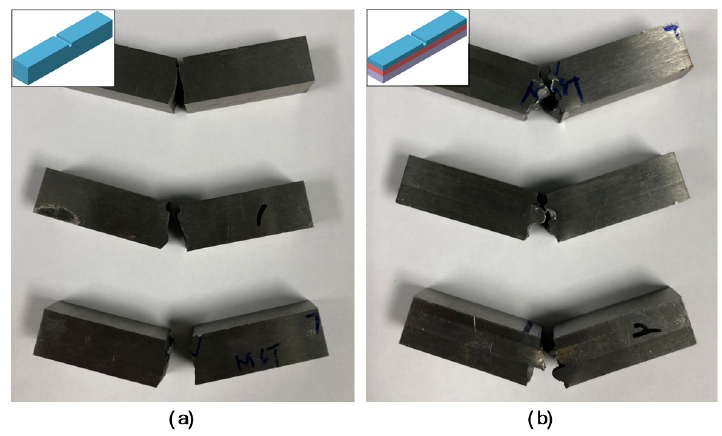
Figure 9. State of the specimens after impact testing for full-AM HWS and HWS- P21 AM specimens: